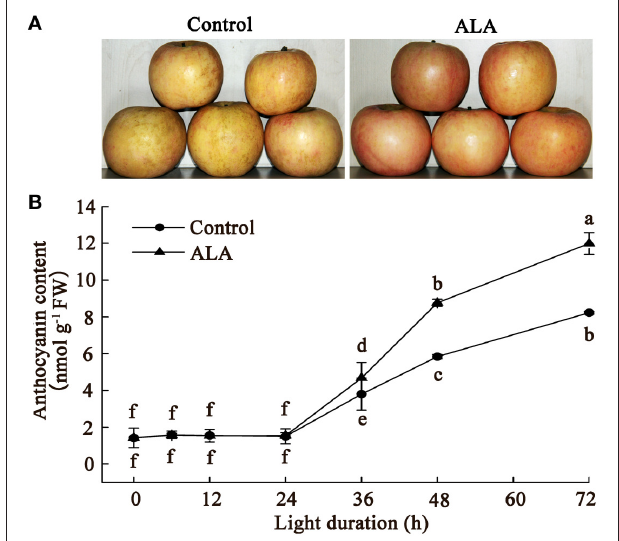
FIGURE 1 | ALA induces anthocyanin accumulation in apple skin. The bagged fruits from Fuji apple trees were collected in early October and immediately transported to the laboratory for 200mg/L ALA treatment and water treatment (control). Then, fruits coloration was induced in a growth chamber with 150 µ mol m − 2 s − 1 photon flux density at 22 ◦ C. (A) A photo displays the color difference between ALA treatment and the control in apple skin at 72h light duration. (B) Time courses of anthocyanin accumulation after ALA application. The different small letters represent significant differences at P = 0.05